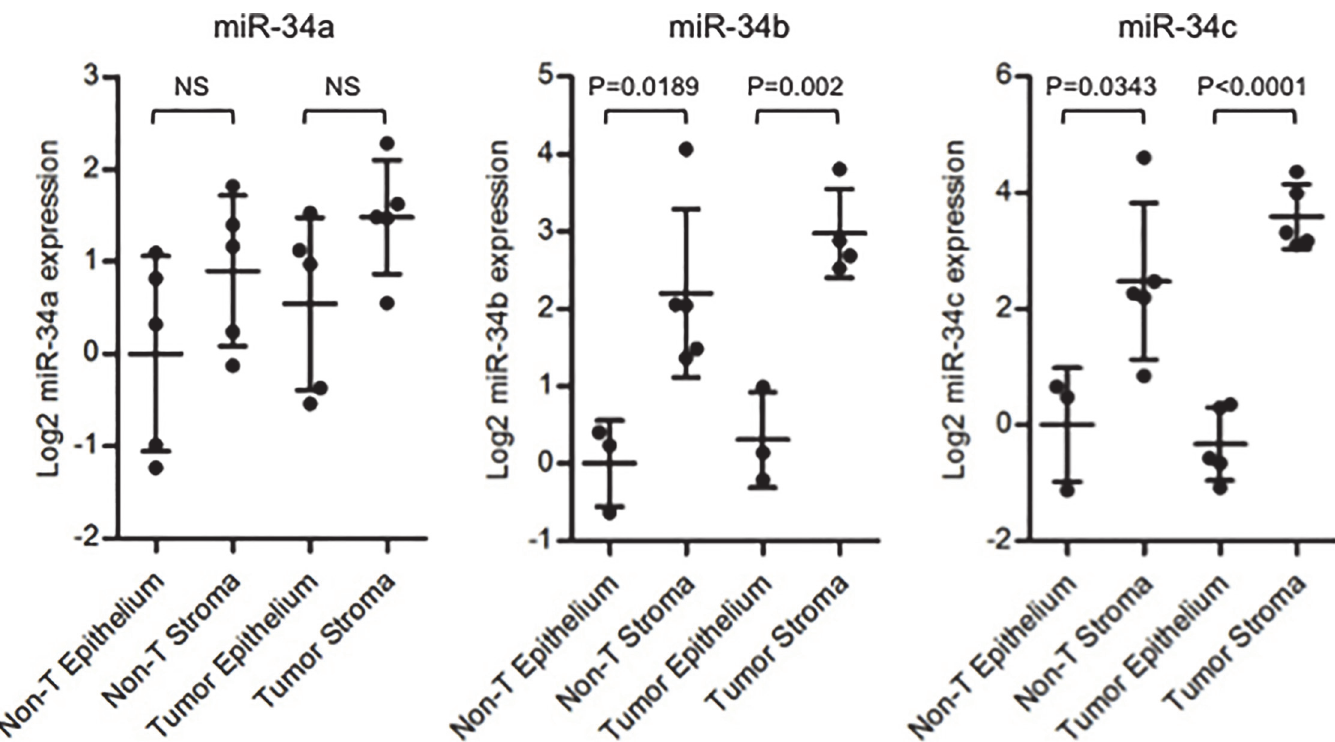
Fig 4. miR-34 family tends to be expressed predominantly in stromal tissue. RNA samples from cancer epithelium, cancer stroma, normal adjacent epithelium and normal adjacent stroma were extracted separately using laser microdissection technique from 5 paired samples in the American cohort. Dot plots represent miR-34a/b/c threshold cycle values of tumor tissue from TaqMan qRT-PCR normalized to U48. Horizontal bars indicate median expression value. Un-paired t test was